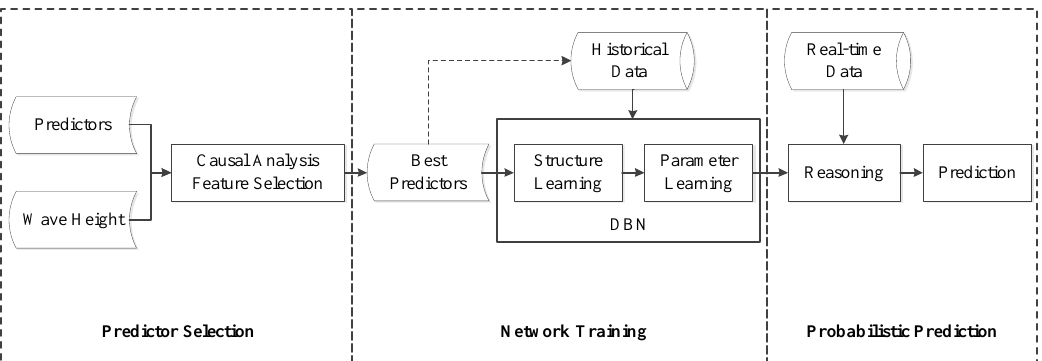
Figure 1. Technical flowchart of dynamic Bayesian network and information flow (DBN-IF model).